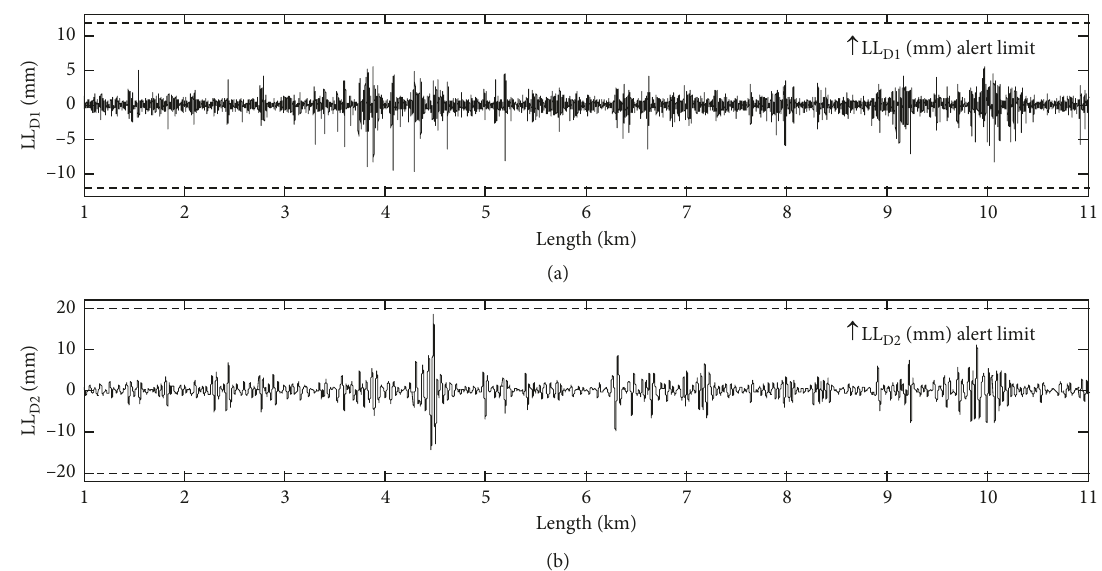
Figure 1: Track longitudinal level, LL, for wavelength ranges (a) D1 (3 < λ ≤ 25 m) and (b) D2 (25 < λ ≤ 70 m) and respective alert limits